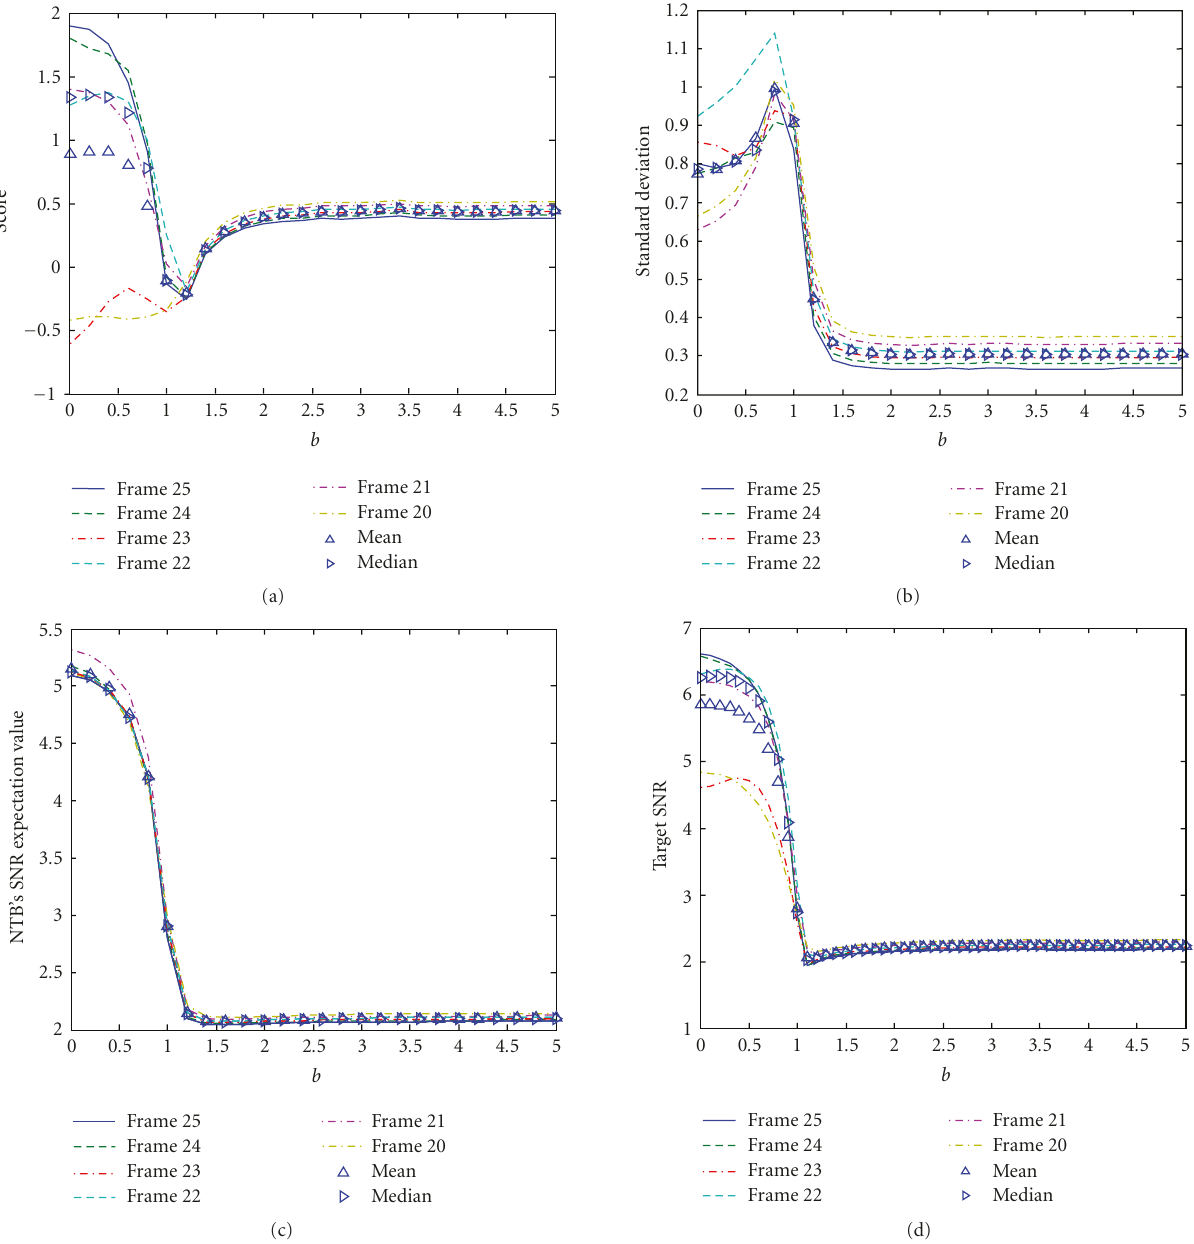
Figure 11: NA23A sequence preliminary results; g = 1, Max Numbers = 5. (a) A S, (b) standard deviation of NTB’s SNR, (c) expectation value of NTB’s SNR, and (d) TB’s